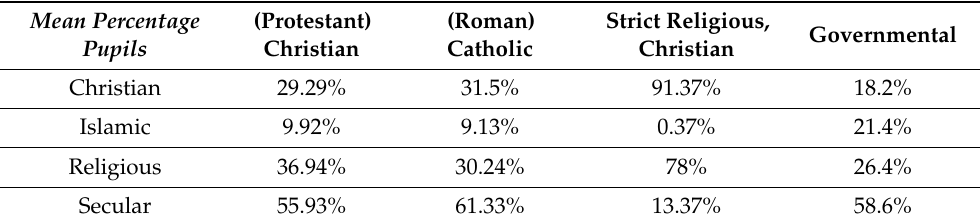
Table 4. Estimated religious backgrounds of pupils (percentages, by school denomination). Mean Percentage (Protestant) (Roman) Strict Religious, Pupils